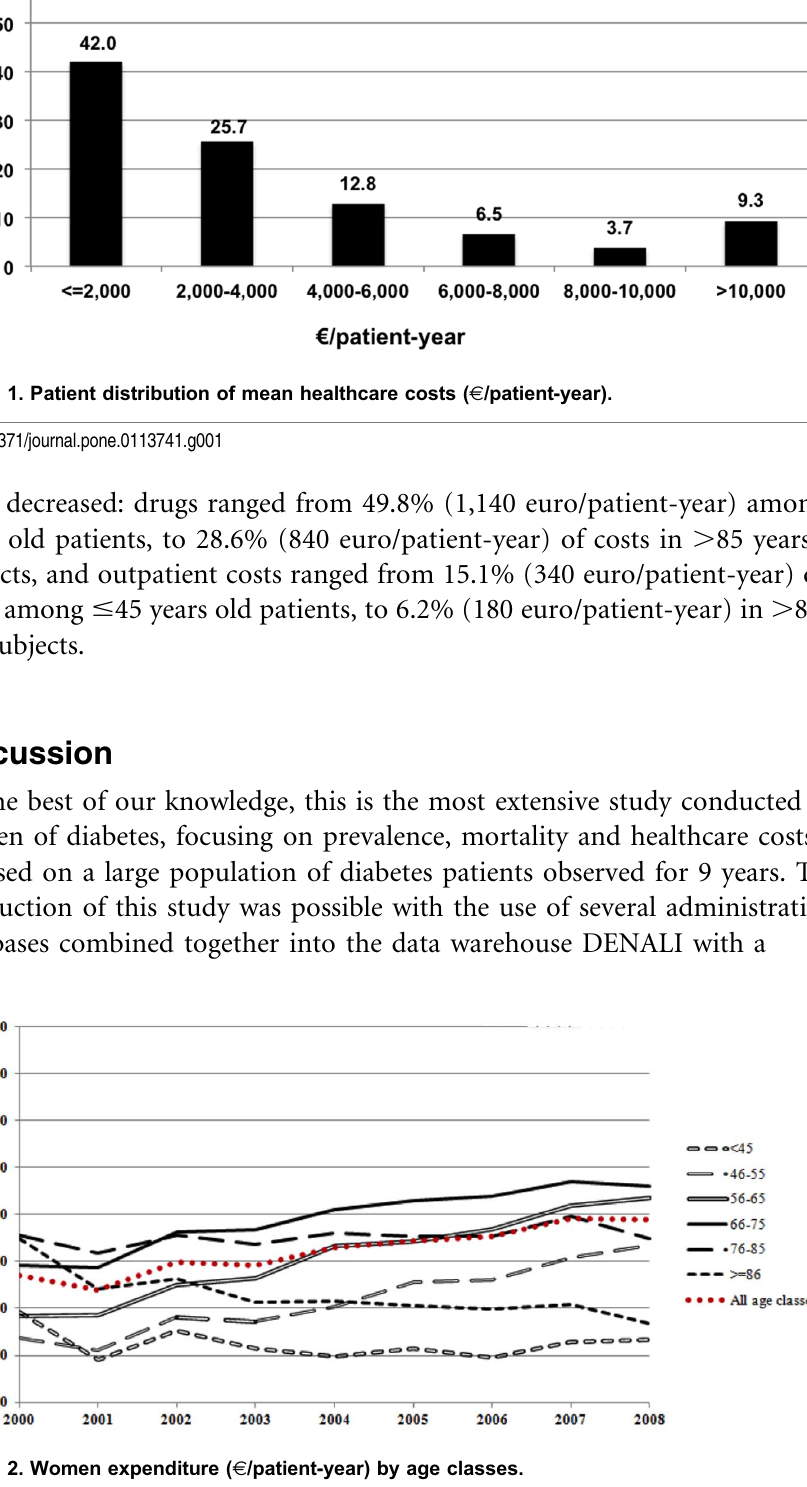
Figure 2. Women expenditure ( J /patient-year) by age